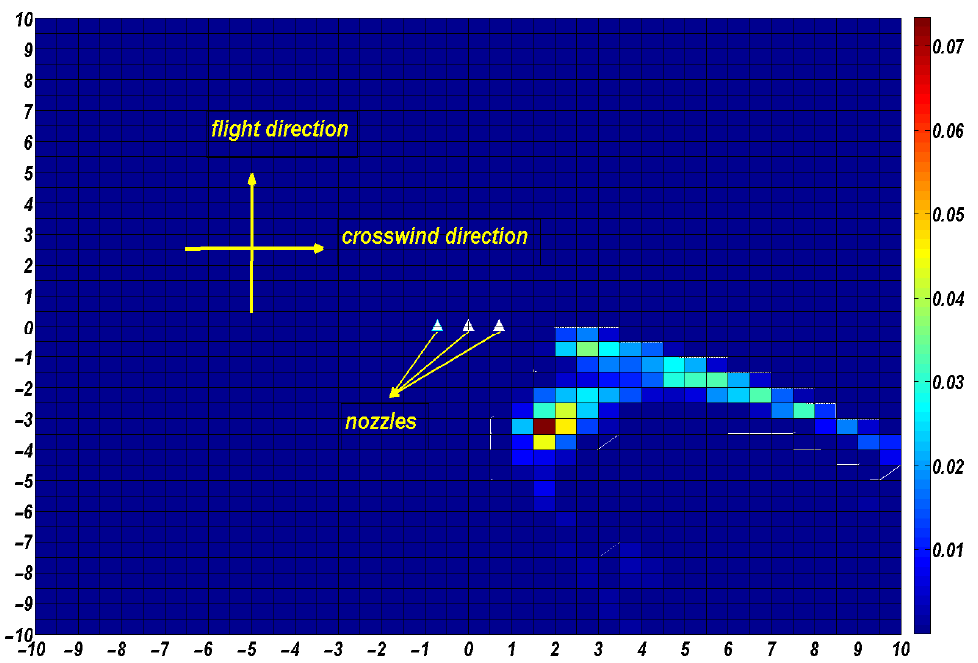
Figure 19. Droplet deposition distribution at a flight height of 3 m, crosswind speed of 2 m/s, and flight speed of 2 m/s , flight direction in the y-axis-positive half-axis direction. Case 2: Flight height of 3 m, flight speed of 2 m/s, flight direction in the y-axis-nega-